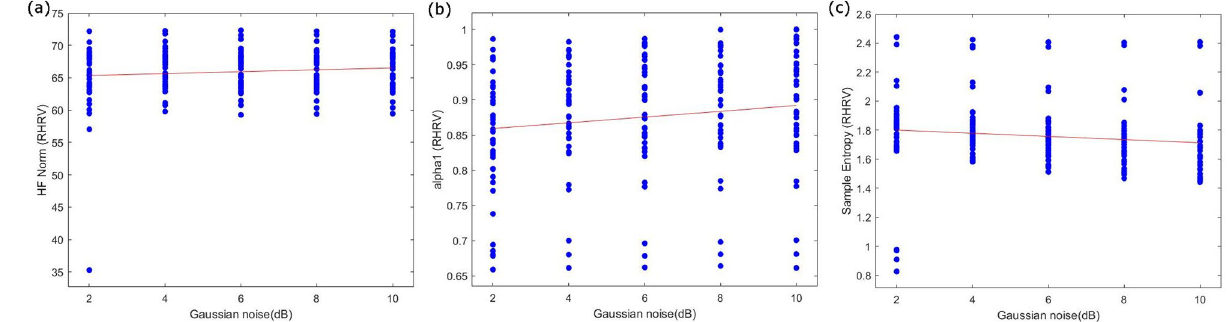
Figure 8. Examples of HRV measures that did not show a linear relationship in the relative change of HRV measure (y axis) with incrementing Gaussian noise (x axis), ( a ) HF-Norm, ( b ) alpha 1, ( c ) Sample